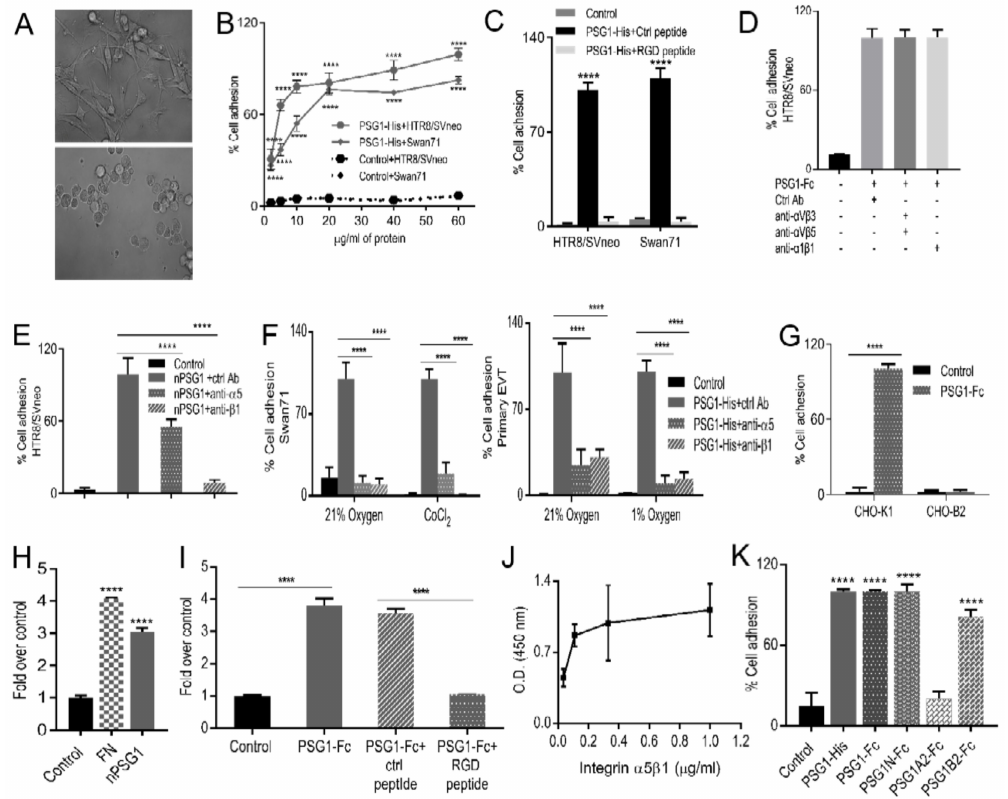
Figure 2. PSG1-mediated adhesion of the EVTs is dependent on a direct interaction with integrin α 5 β 1. Micrographs of Swan71 cells on wells coated with 30 µ g / mL PSG1-Fc for 1.5 h in serum-free media ( A , top) or a protein consisting of just the Fc-tag used as control ( B , bottom). Images were taken at 40 × magnification. ( B ) HTR8 / SVneo and Swan71 cells were seeded in wells coated with PSG1-His or control protein at various concentrations. Cells were incubated for 2 h at 37 ◦ C and the wells were washed to remove non-adherent cells. Cells remaining in the wells were incubated with cell titer aqueous solution and cell adhesion was quantified as described in Materials and Methods. The adhesion of Swan71 cells to wells coated with 60 µ g / mL PSG1-His is considered as 100%. ( C ) HTR8 / SVneo and Swan71 cells, pre-incubated with 500 µ M RGD peptide or control (ctrl) peptide for 30 min at room temperature were seeded in wells coated with 30 µ g / mL PSG1-His or control protein. The adhesion of control peptide-treated cells to PSG1-His is considered as 100%. ( D ) HTR8 / SVneo cells were pre-incubated with the indicated mAbs for 30 min at RT, after which they were seeded in wells coated with 30 µ g / mL PSG1-Fc or control protein. ( E ) HTR8 / SVneo cells were pre-incubated with the indicated mAbs for 30 min at RT and seeded on wells coated with 30 µ g / mL of native PSG1 (nPSG1) or control protein. ( F ) Swan71 cells and purified primary EVTs, pre-incubated with the indicated mAbs were seeded on wells coated with 30 µ g / mL PSG1-His or control protein and adhesion assays were performed in 21% oxygen and CoCl 2 -induced hypoxic-like condition or in 1% oxygen conditions as described in Materials and Methods. The adhesion of control Ab-treated cells to PSG1 is considered as 100% in ( D ), ( E ) and ( F ). ( G ) CHO-K1 (integrin α 5-expressing) or CHO-B2 (integrin α 5-deficient) cells were seeded on wells coated with 30 µ g / mL PSG1-Fc or control protein. The adhesion of CHO-K1 cells to PSG1-Fc is considered as 100%. ( H ) nPSG1 or protein control at 20 µ g / mL or bovine fibronectin (FN) at 2 µ g / mL was coated on wells. After blocking, 1 µ g / mL of α 5 β 1 in 1 × TBS / 1mM MnCl 2 was added and binding of the integrin was detected with biotin-labeled anti- β 1 mAb followed by Streptavidin-HRP. I. Wells were coated with PSG1-Fc or protein control (20 µ g / mL). After blocking, 1 µ g / mL of α 5 β 1 in 1 × TBS / 1 mM MnCl 2 was added in combination with 0.5 µ M RGD or control peptides and binding of the integrin was detected as indicated in ( H ). The binding of the integrin to the control protein is considered as 1 in ( H ) and ( I